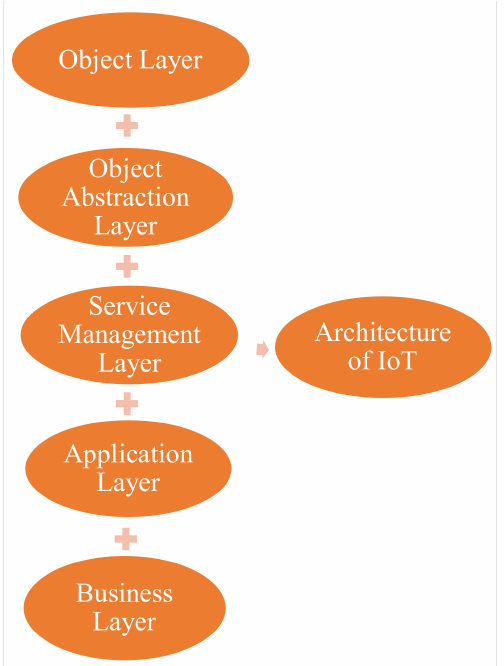
Figure 4. Architecture of